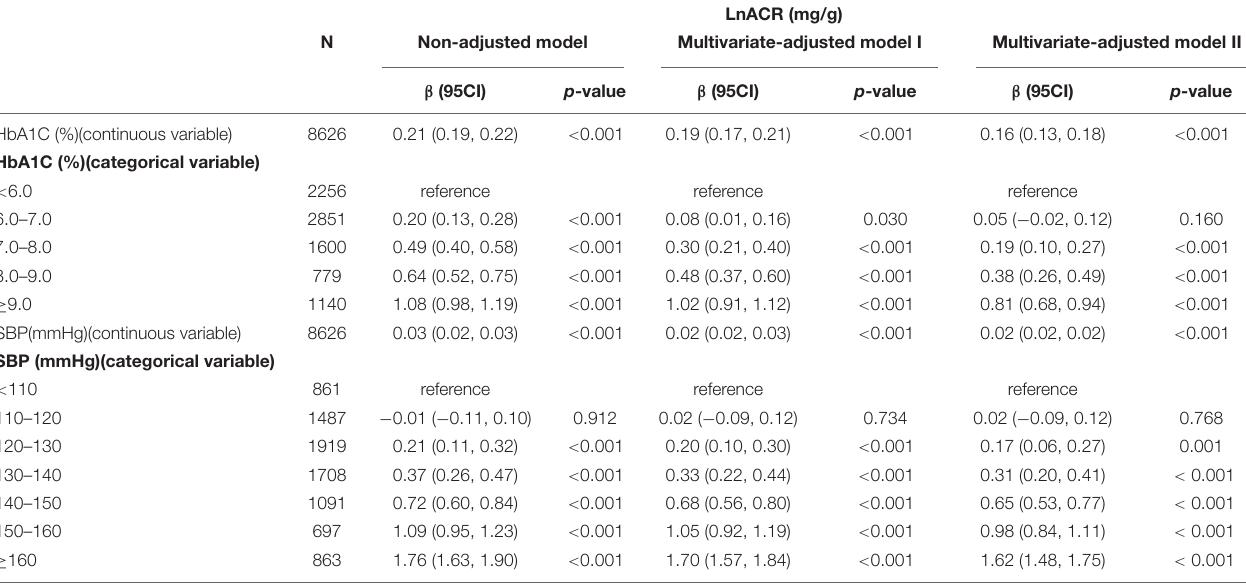
TABLE 2 | The relationship between ACR and HbA1c or SBP using linear regression